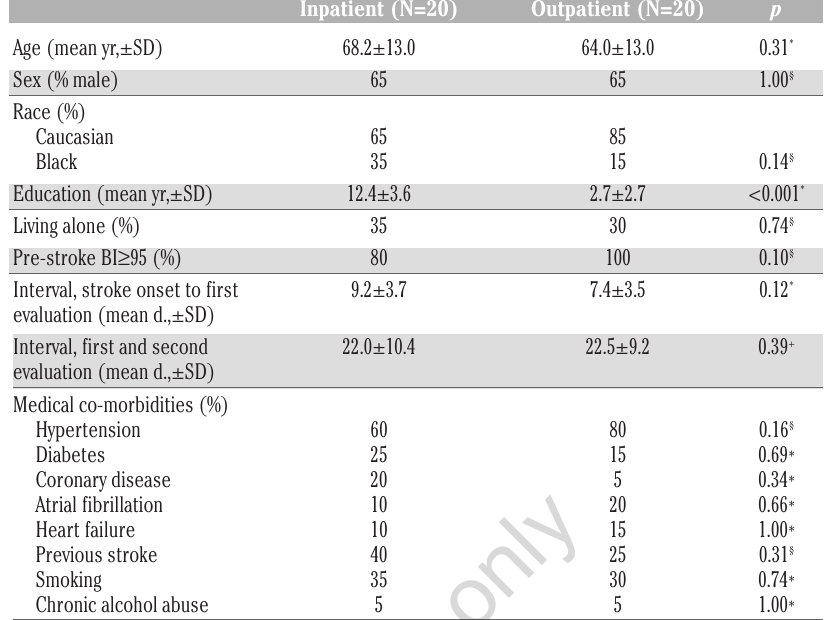
Table 1. Demographic characteristics of the inpatient and outpatient groups.